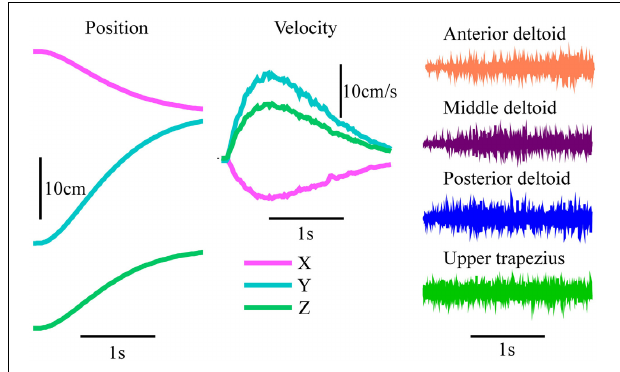
FIGURE 2 | Example training reach and EMG. Automatically generated robot kinematics and EMG signals produced by one subject from Group 1 as they assisted the reach during the training